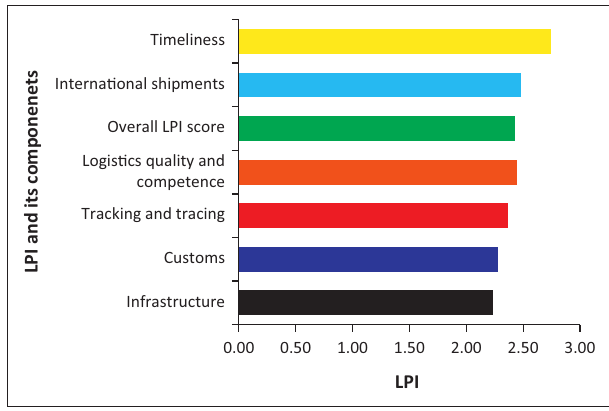
LPI, logistics performance index. FIGURE 3: Logistics performance index of